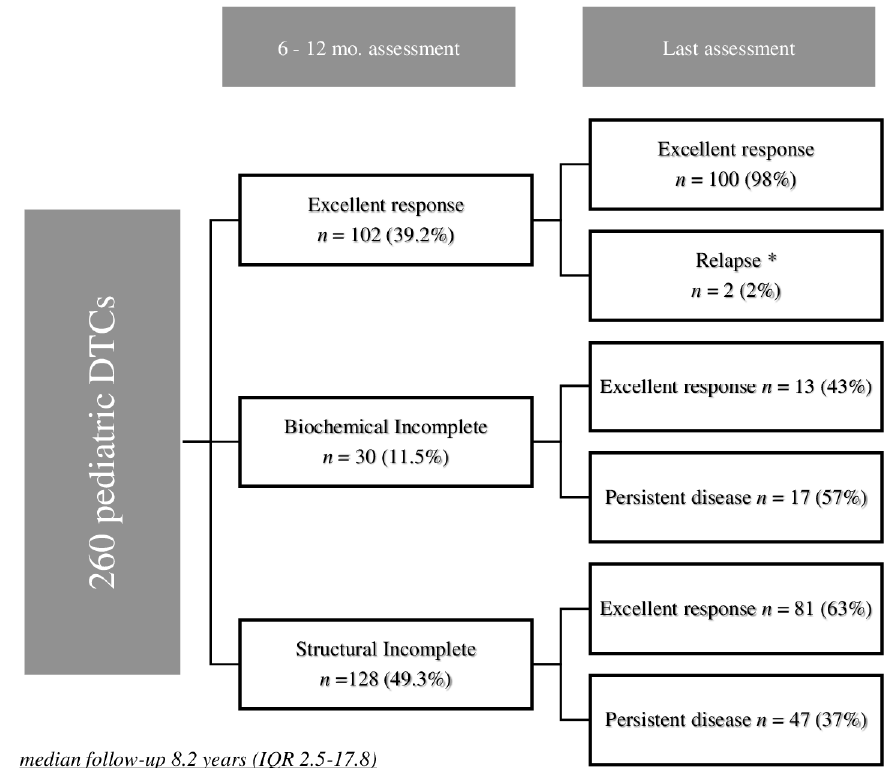
Figure 1. Outcome at 6–12 months after initial treatment and at last follow-up in 260 pediatric DTCs. * A total of 1 BIR (appearance of TgAb) needing a second RAI with a negative WBS had ER at last visit; 1 SIR (metastatic LN on ultrasound) needing neck surgery and RAI had SIR (small LN) at the last visit.